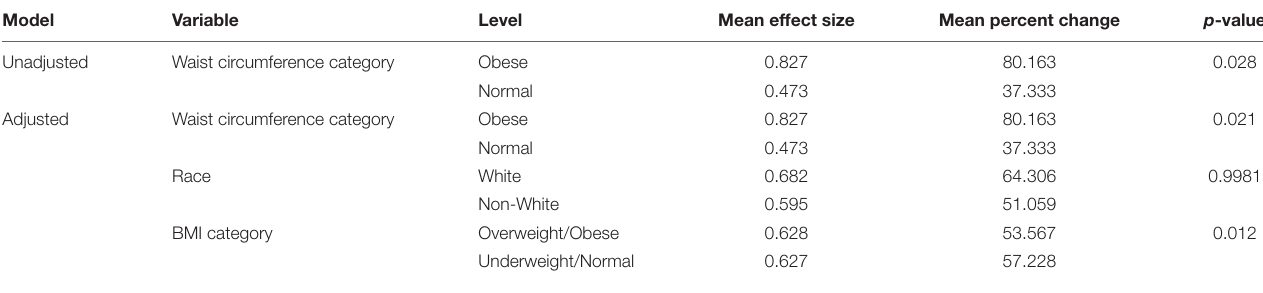
TABLE 4 | Mean Effect Size and Percent Change of Premenstrual Food Craving Increase for the Normal and Obese Study Groups (Unadjusted and Adjusted Models).